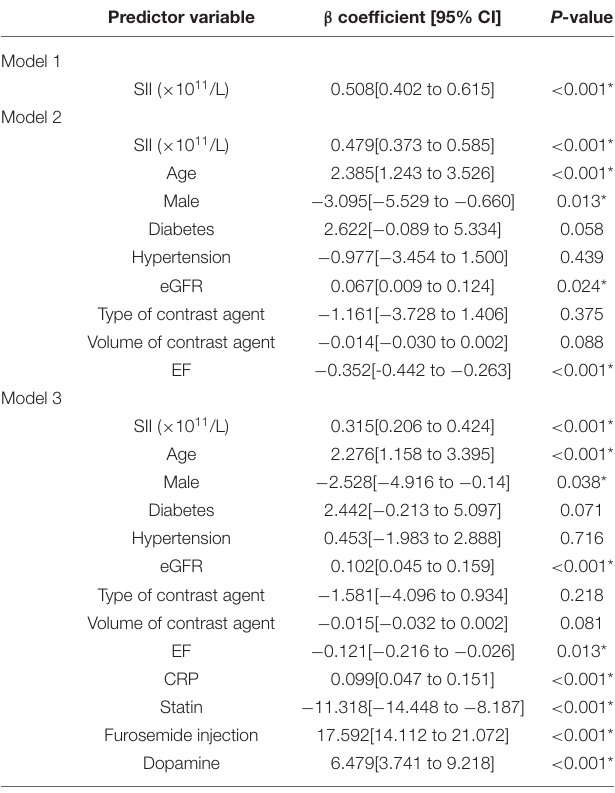
TABLE 2 | Linear regression analyses of SII on the proportion of elevated Scr. Predictor variable β coefficient [95% CI] P-